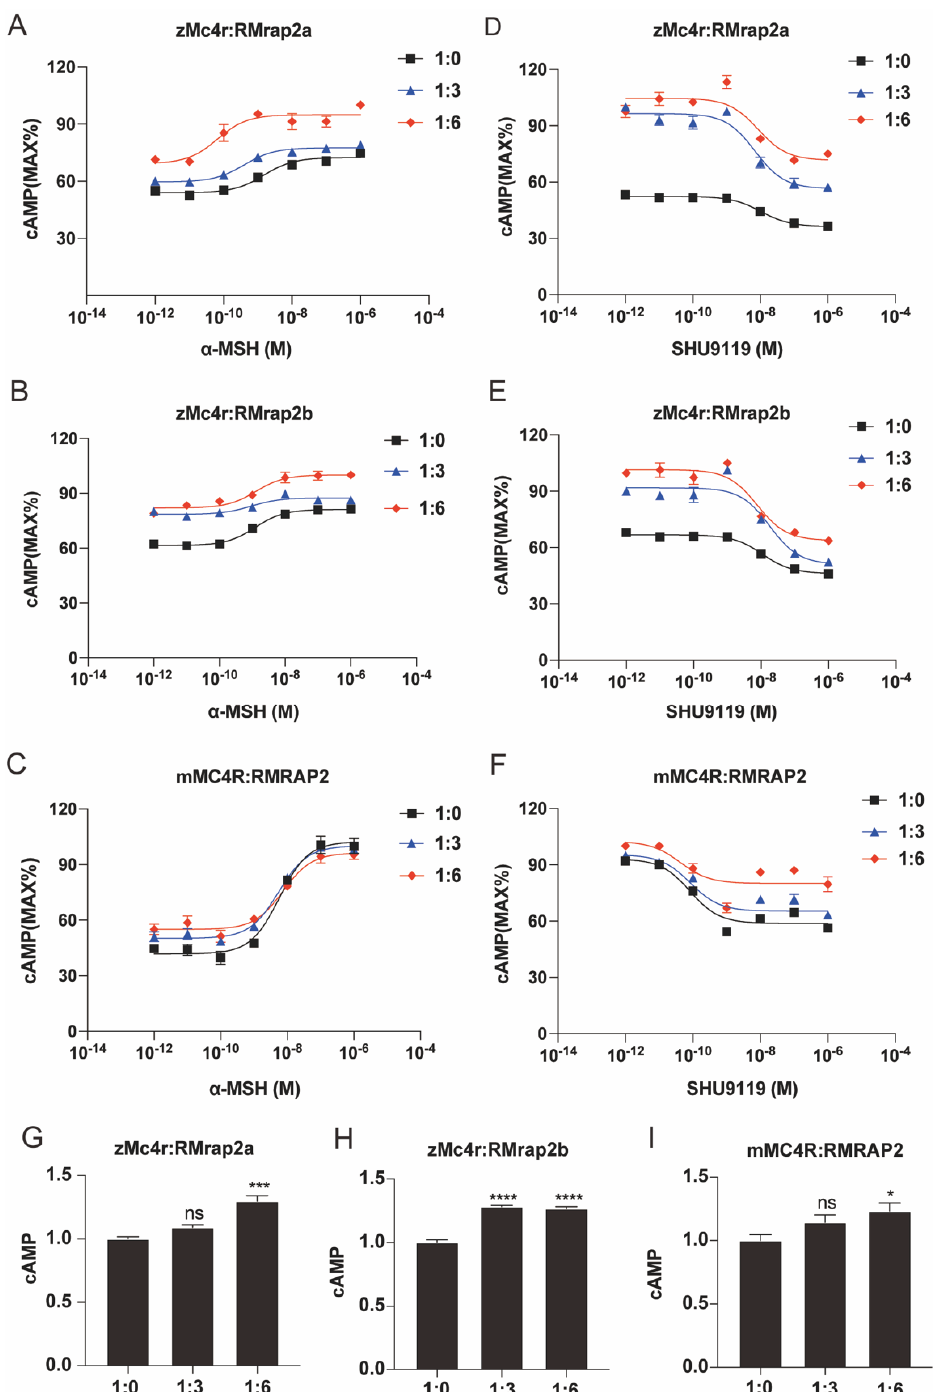
Figure 5. Pharmacological modulation of zMc4r signaling by RMrap2a/b. ( A – C ) Dose–response stimulation of MC4R by α− MSH − induced cAMP production in the presence of different amounts of RMrap2a/b ( A , B ) or RMRAP2 ( C ). ( D – F ) Dose–response inhibition of MC4R by antagonist SHU9119 in the presence of different amounts of RMrap2a/b ( D , E ) or RMRAP2 ( F ). ( G – I ) The constitutive activity of MC4R in different dosages of RMRAP2. Data were analyzed by one − way ANOVA and shown as mean ± SEM of three replicates. ns (not significant difference), * p < 0.05, *** p < 0.001 and **** p < 0.0001.